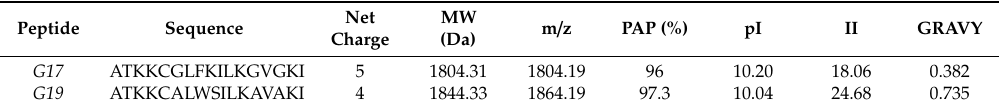
Table 1. Physicochemical properties of peptide G17 and G19 calculated using ExPASy ProtParam tool and CAMP R3 software.